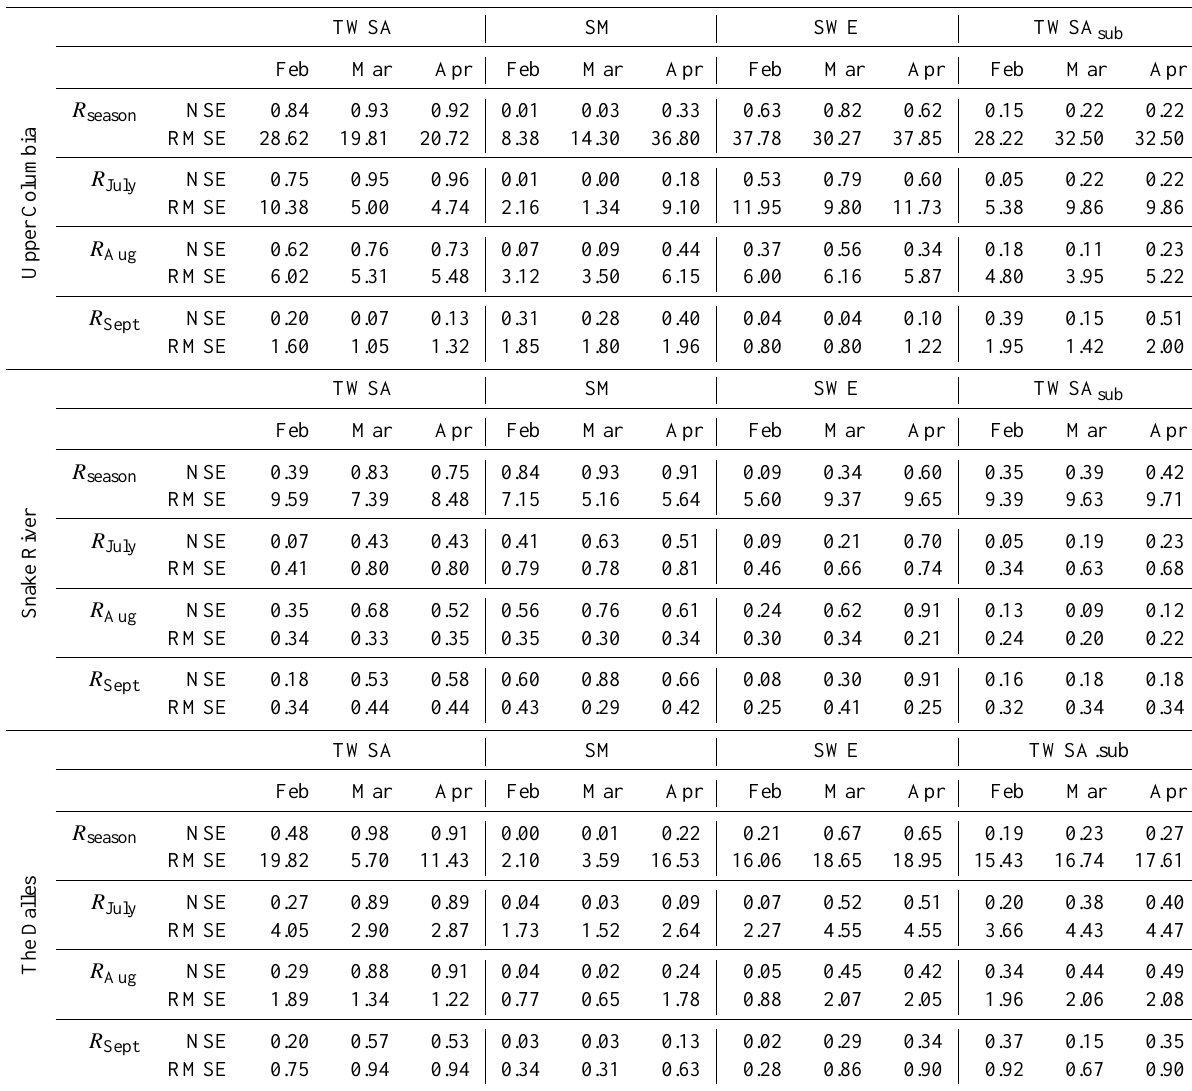
Table A4. Comparison of performance metrics from applying all 9 water years of GRACE TWSA, model-derived snow (SWE), soil moisture (SM), and subsurface (TWSA sub ) data in predicting seasonal ( R season ) and August ( R Aug ) runoff by watershed. RMSE values are in mm. R 2 values are the same as NSE for this linear